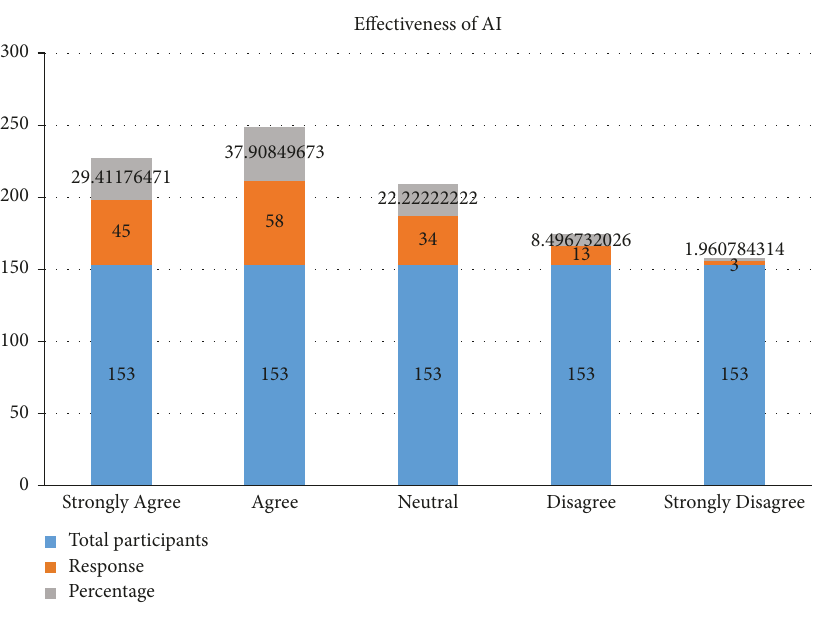
Figure 6: Effectiveness of